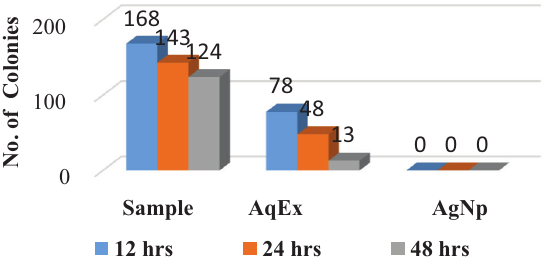
Figure 6 . Total bacterial count in Xylose – Lysine Deoxycholate Agar ( Shigella ) – values are expressed as Mean ( n = 3)